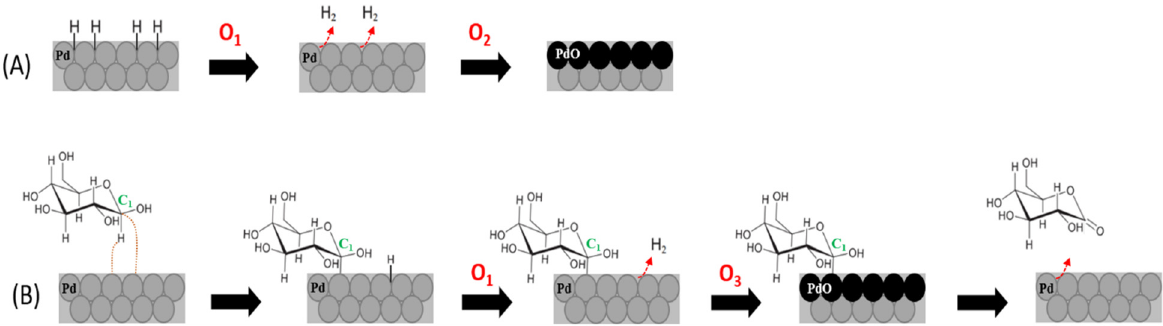
Scheme 1. Schematic representation of the mechanism proposed for ( A ) the dehydrogenation and oxidation of PdNS and ( B ) glucose oxidation on the PdNS catalyst in neutral pH.